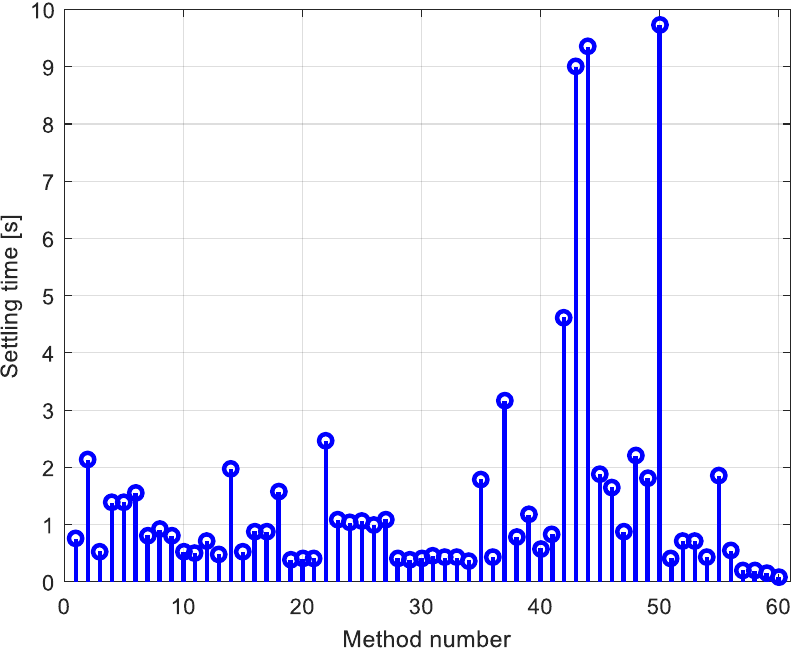
Figure 4. Settling time of the generator voltage.